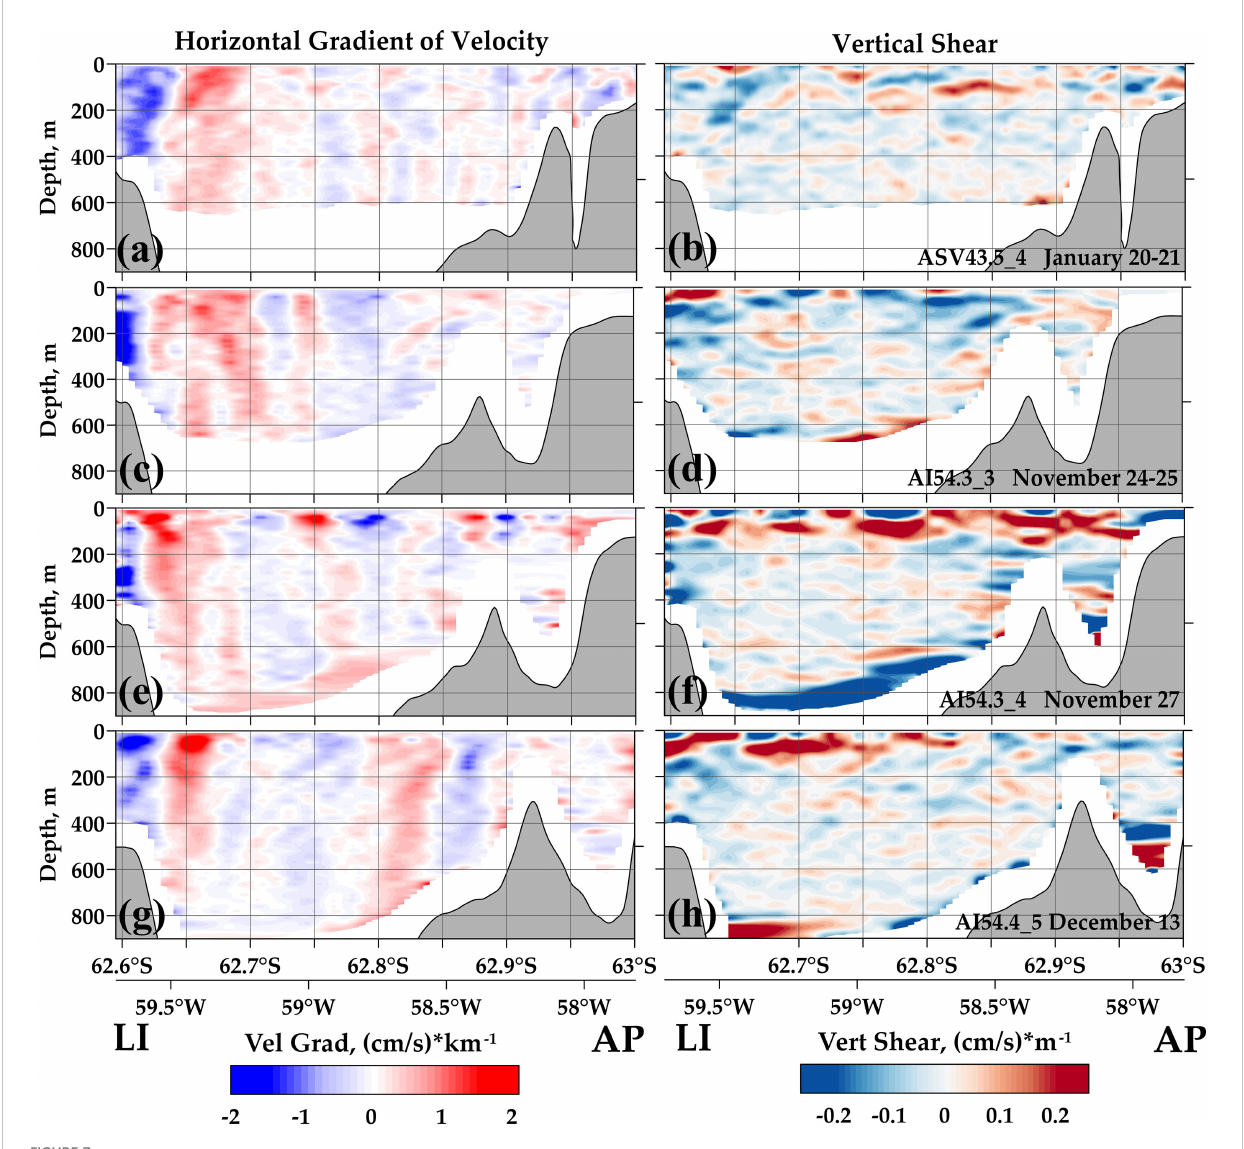
FIGURE 7 Distributions of horizontal gradient of velocity (left panels) and vertical shear (right panels) at four crossings between Livingston Island (LI) and Antarctic Peninsula (AP) performed on January 20-21 (A, B) , November 24-25 (C, D) , November 27 (E, F) , and December 13 (G, H) . The measurements were performed from the R/V ASV (A, B) and R/V AI (C – H) . Locations of the crossings are shown in the right panels of Figure 6. The ocean bottom is shown by grey